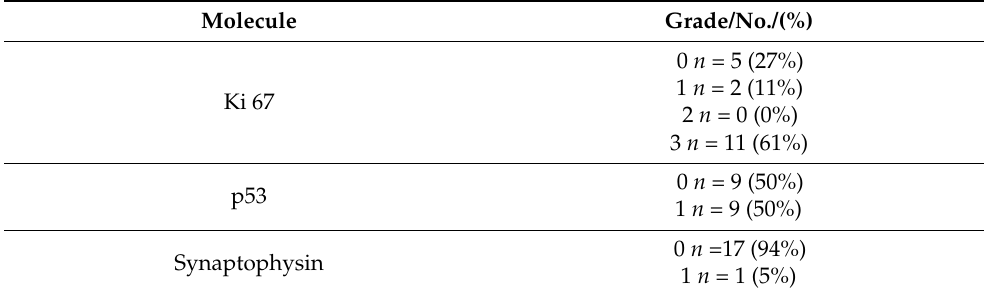
Table 4. Cont . Molecule